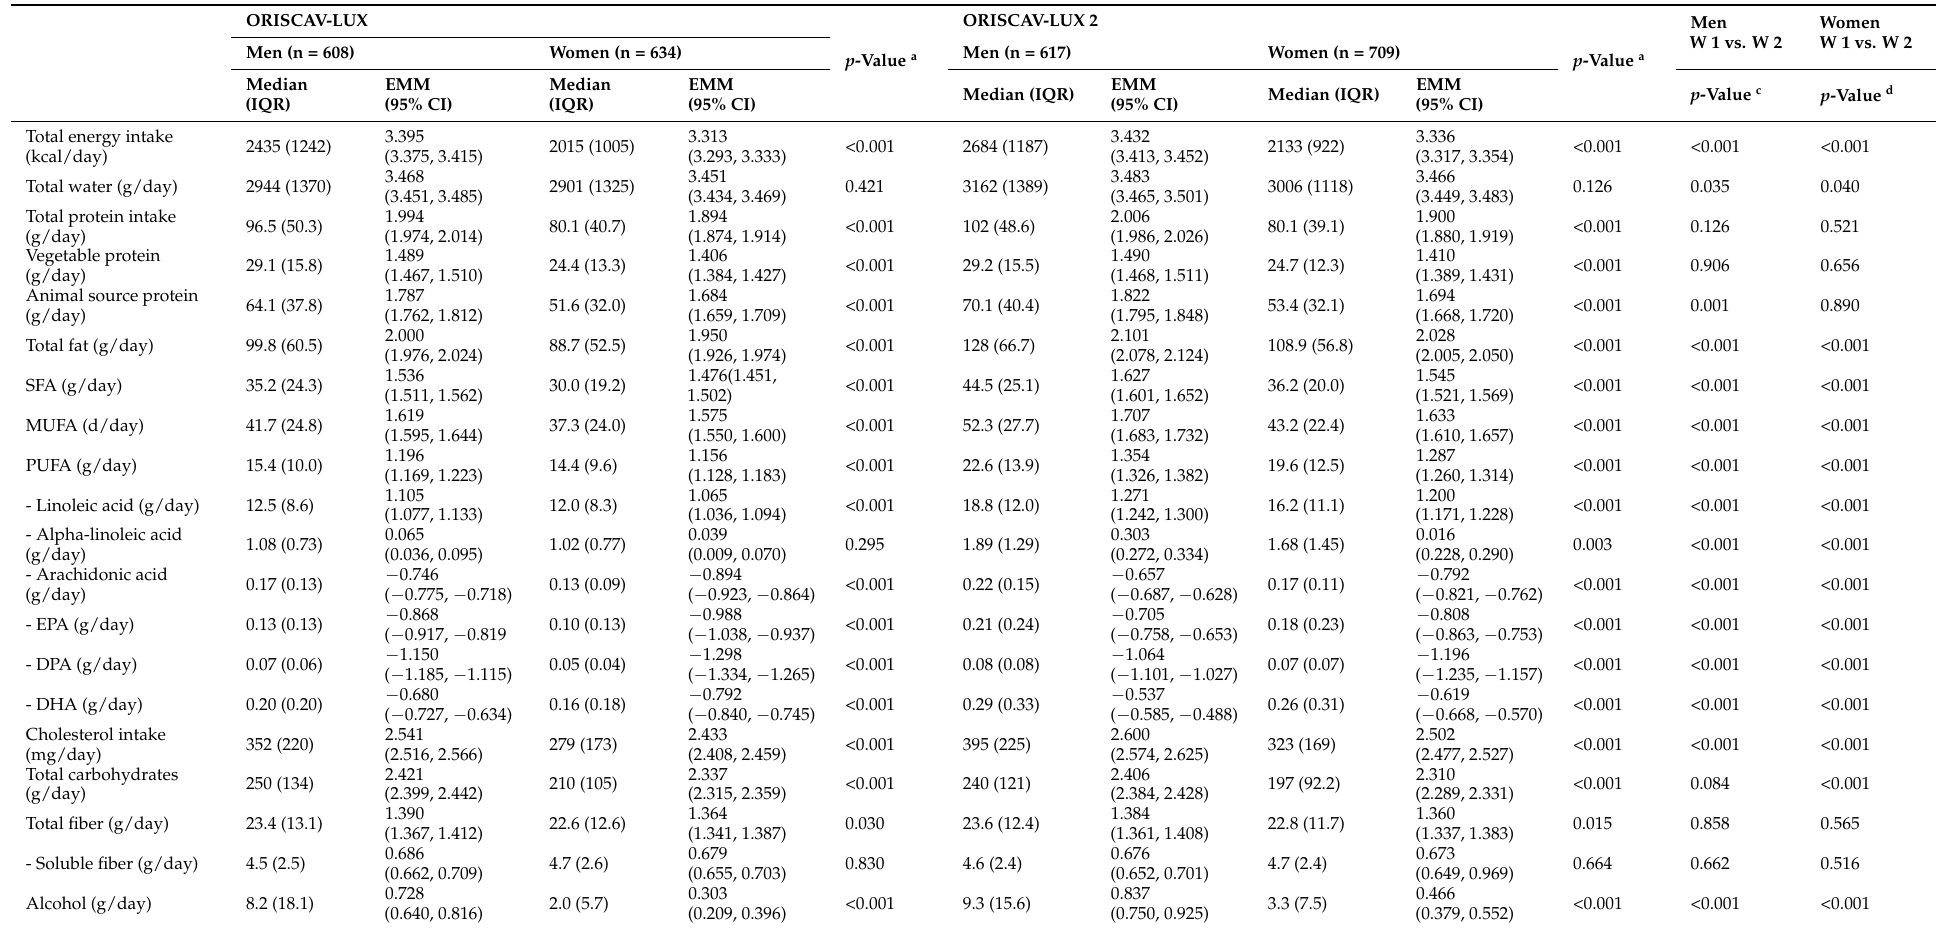
Table 5. Within- and between-group comparisons * of macronutrients based on gender groups ( p -values are based on linear mixed model) e .